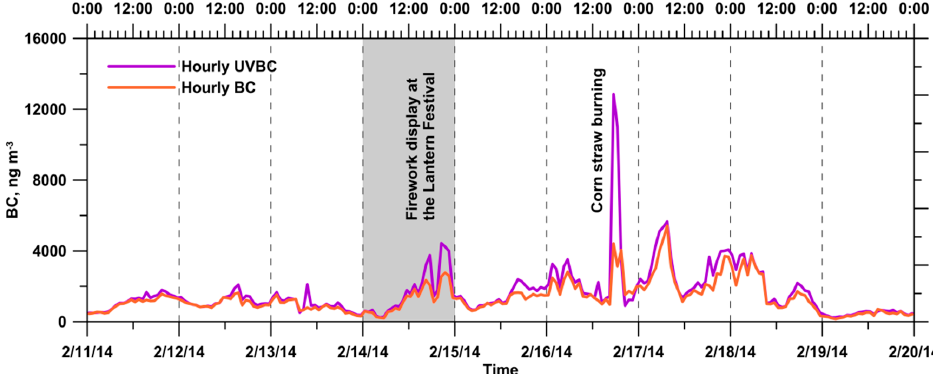
Figure 4. Time variations of the hourly UVBC and BC concentrations at the monitoring site during the whole monitoring